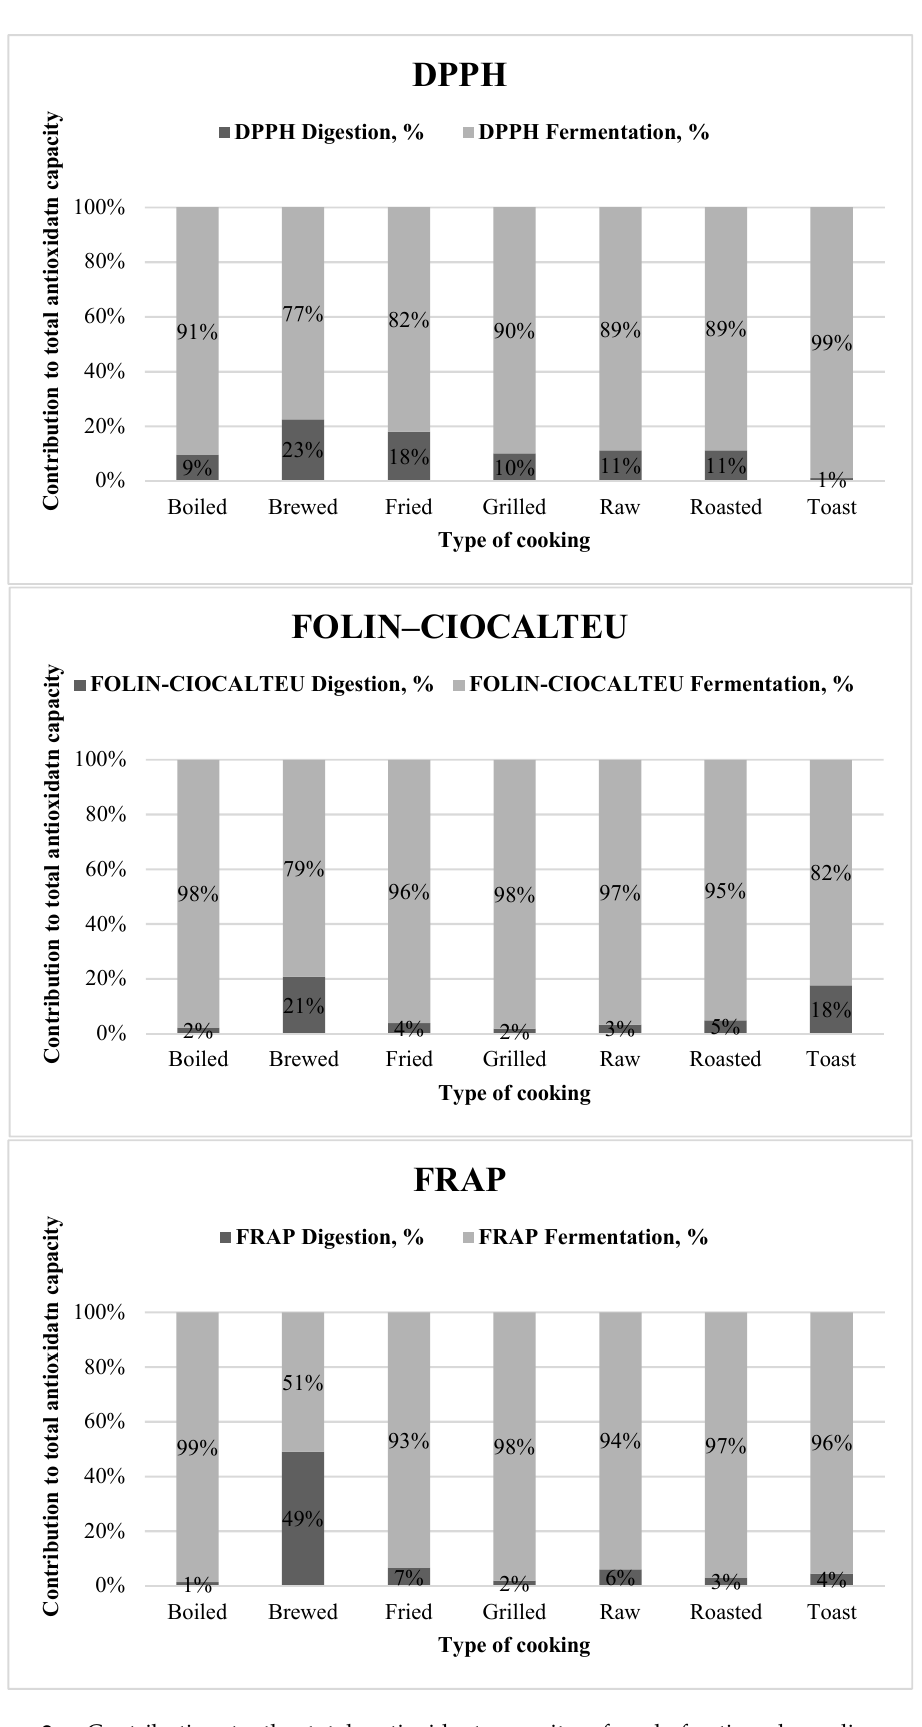
Figure 2. Contribution to the total antioxidant capacity of each fraction depending on the cooking technique.